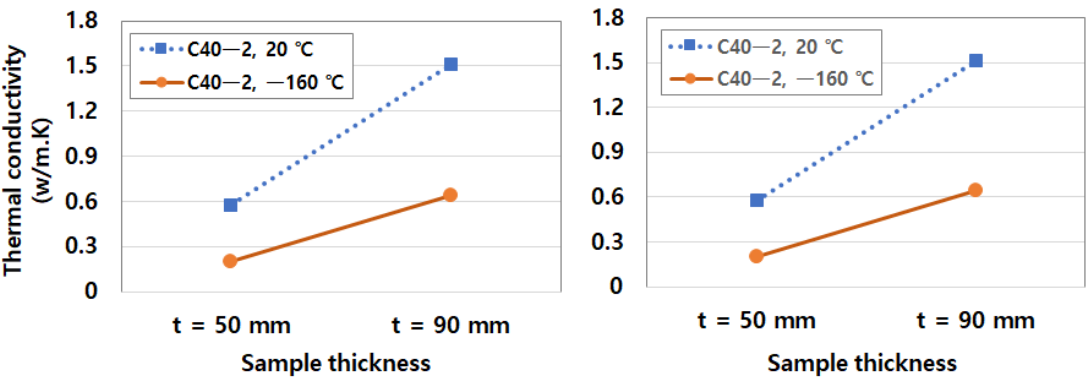
Figure 11. Effect of sample thickness on thermal conductivity.